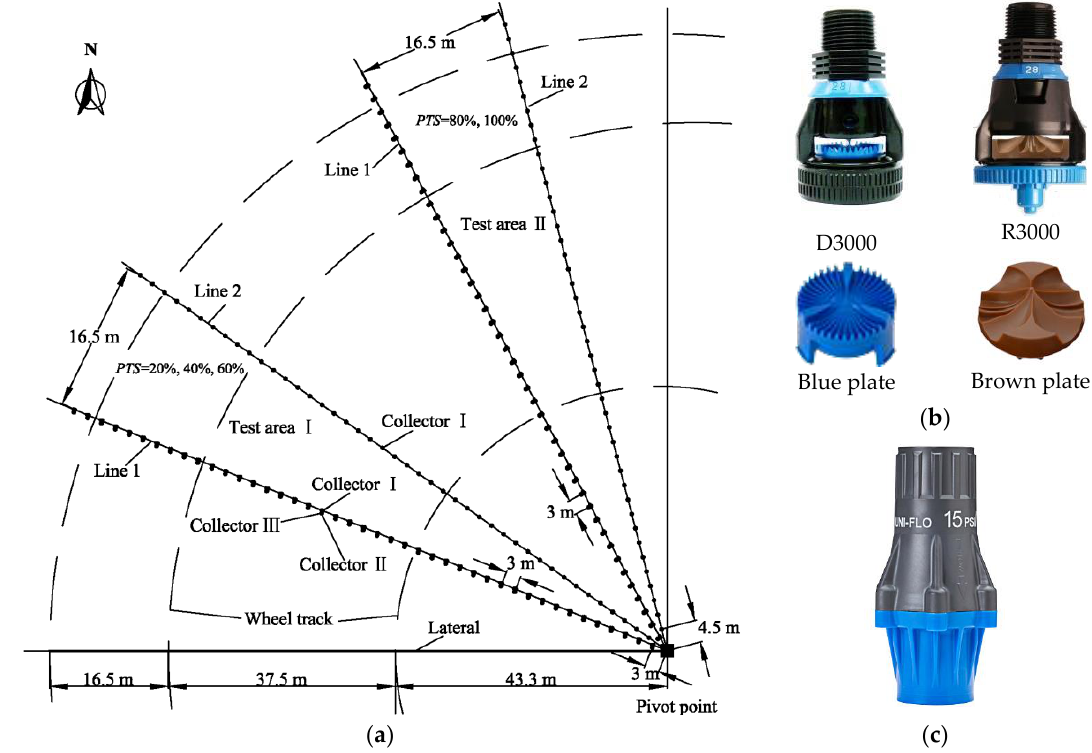
Figure 3. Schematic diagram of the experimental apparatus used to evaluate the performance of the center pivot irrigation system: ( a ) schematic diagram of the experiment; ( b ) FSPS with blue fixed spray-plates (D3000) and RSPS with brown rotated spray-plates (R3000); and ( c ) pressure regulator (103 kPa).